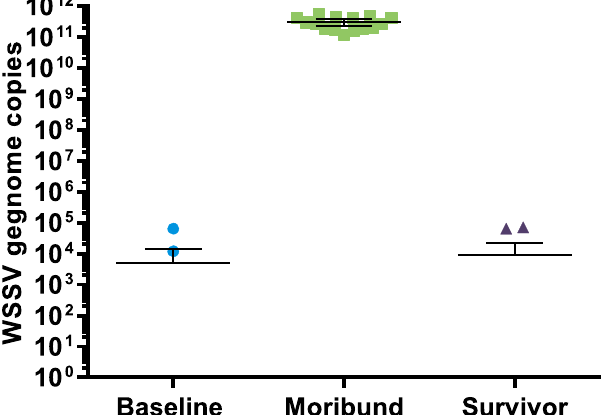
Figure 4. qPCR detection of WSSV in experimental animals. DNA isolated from uropods from shrimp collected at different time points before, during and after challenge was subjected to a qPCR assay detecting WSSV VP28. Cq-values from individual shrimp were compared to a standard curve, made up of 10-fold serial dilutions of a plasmid containing a VP28 insertion, to obtain absolute quantities of WSSV genome copy numbers. The Y-axis represents the absolute WSSV genome copy numbers obtained from each individual shrimp sample. Error bars indicate the 95% CI around the mean.